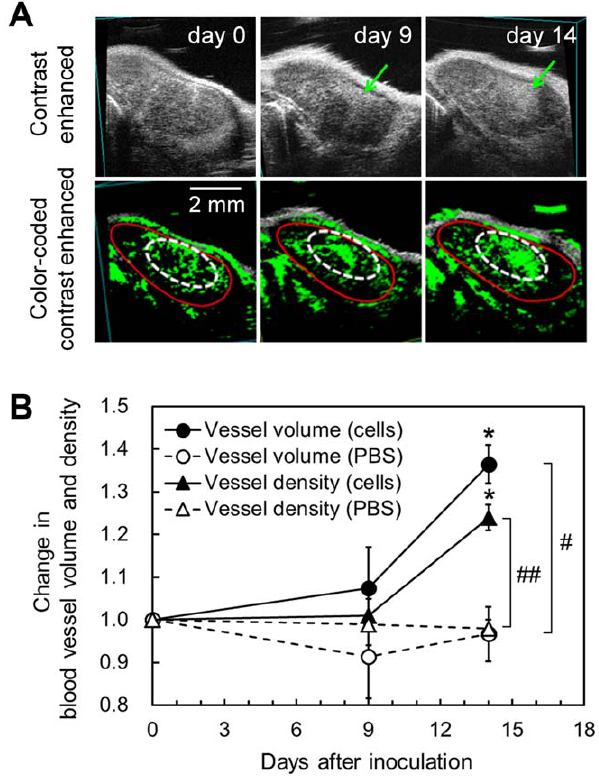
Figure 4. Monitoring of metastatic progression by CE-HFUS with Als. A. Imaging of the temporal changes in angiogenic vessel density in a cross-section of a metastatic proper-ALN, visualized by CE- HFUS with ALs. Blood vessel density increased with tumor progression. Red circles indicate the proper-ALN boundary, arrows and dotted lines indicate the AL-enhanced region, and green highlighting indicates the dense area of neovasculature in the proper-ALN. B. Results of 3D quantitative analysis of the temporal changes in blood vessel volume and density in metastatic proper-ALNs. The term ‘‘cells’’ indicates the metastasized group (1 6 10 5 cells/min, n =4) and ‘‘PBS’’ the negative control group ( n =3). Values for each group were normalized against the measurement on day 0. Error bars indicate the SEM values. * is for comparison of the temporal change within each group; # is for comparison between groups. * or # , P , 0.05; ** or ## , P , 0.01, calculated using two-way ANOVA followed by the Tukey-Kramer test. tases (0.2 mm , tumor cell clusters # 2 mm) and macrometastases (tumor cell clusters . 2 mm) [38]. Some studies have revealed a significant relationship between the presence of isolated tumor cells or micrometastases in lymph nodes and poorer prognosis [39,40], whereas others have failed to find such an association [41–43]. However, lymph node macrometastases larger than 2 mm (on the basis of cluster size) have been established to be of prognostic significance [39].